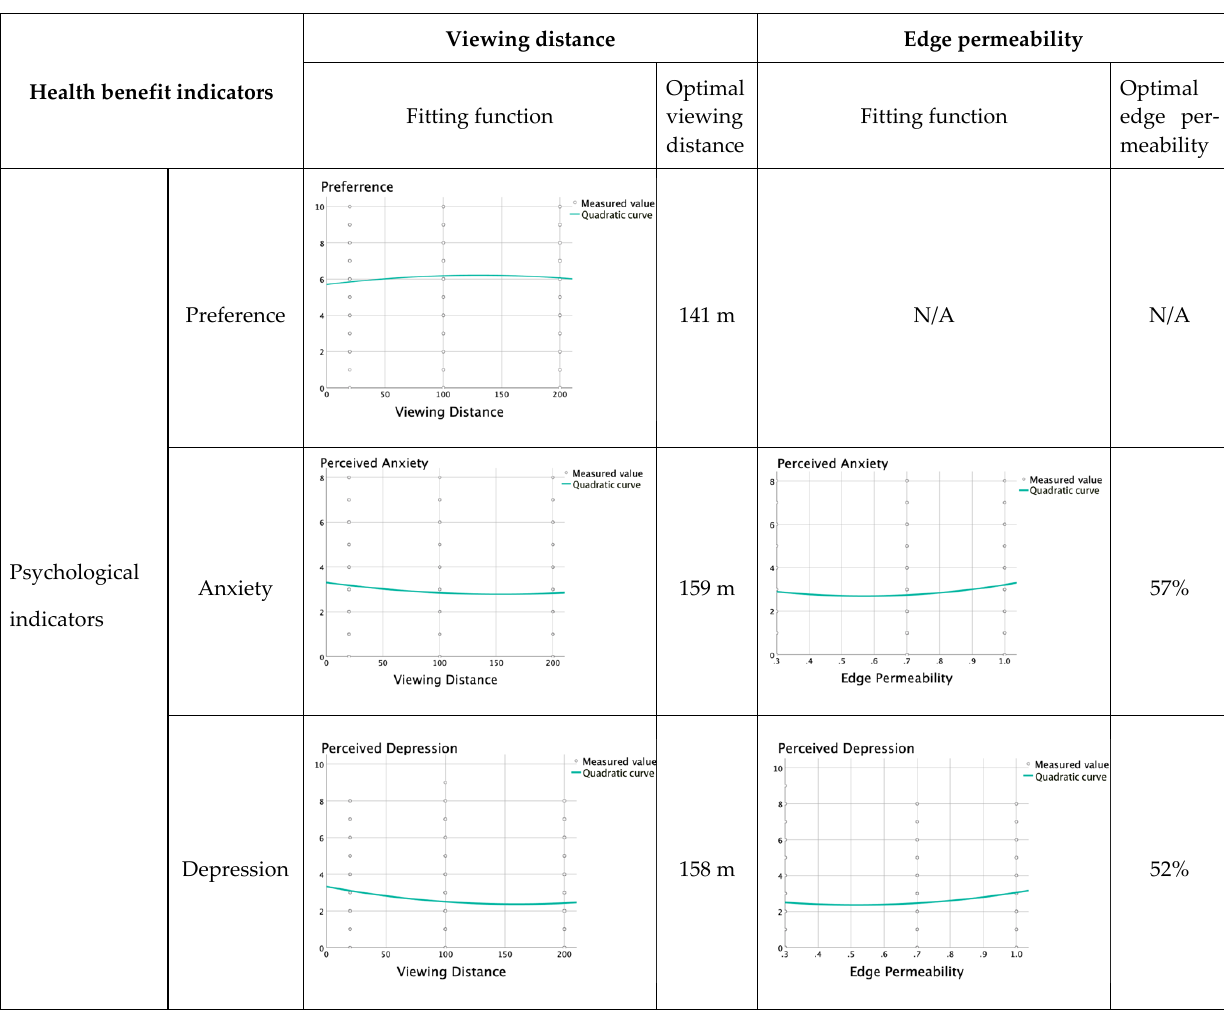
Figure 6. Optimal viewing distance and edge permeability of the grassland landscape.